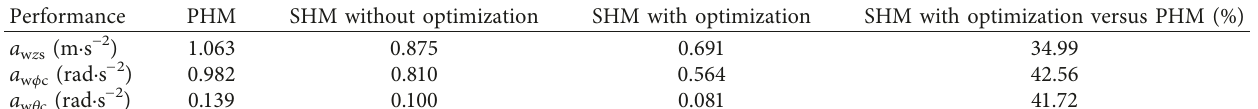
Table 1: The weighted RMS acceleration responses on a deformable terrain.